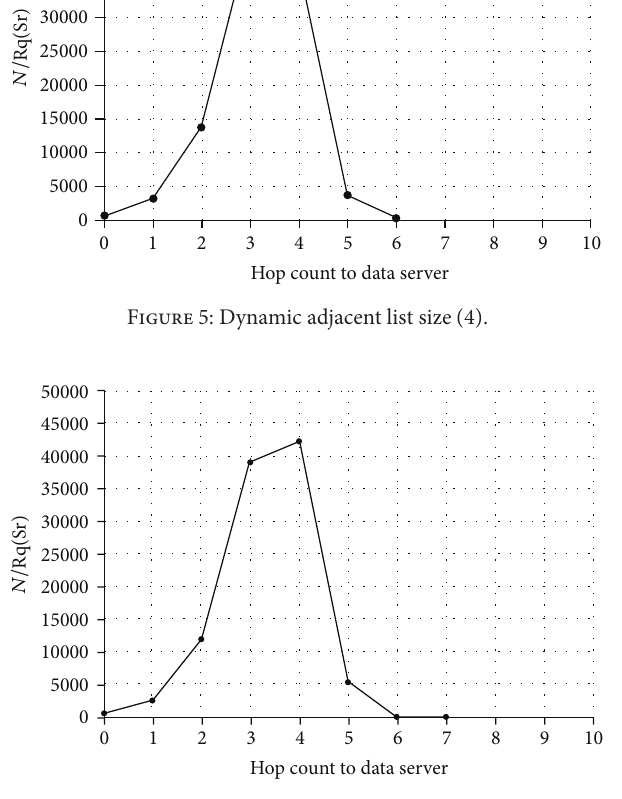
Figure 6: Static adjacent list size (4) .